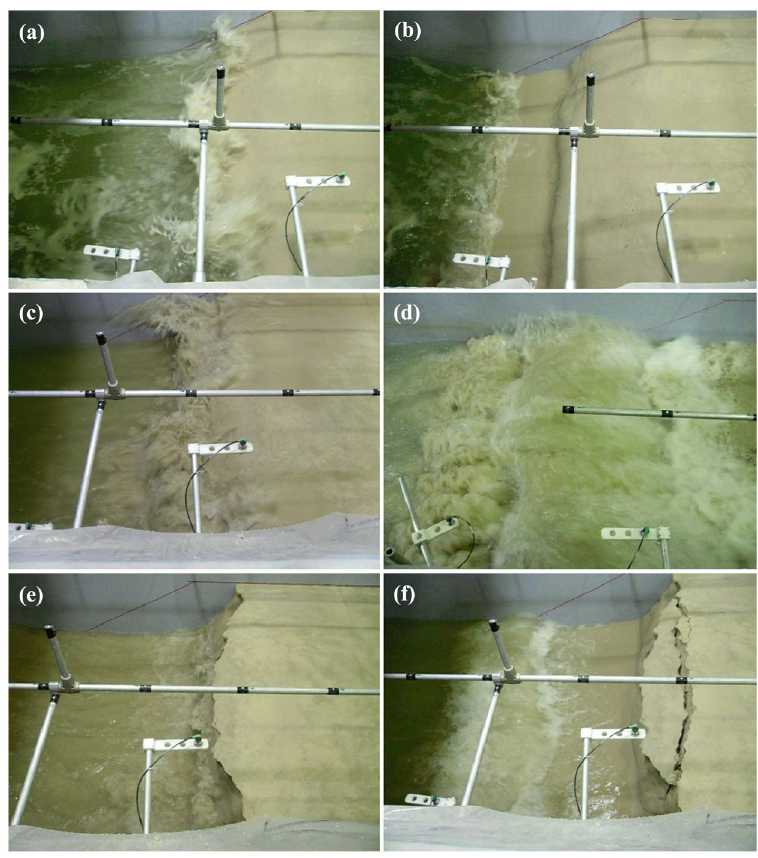
Figure 4. Observed collision regime. ( a ) Wave breaking on the sloping dune front, ( b ) formation of the dune scarp, ( c ) wave breaking and high sediment suspension in the proximity of the dune, ( d ) wave collision, ( e ) dune erosion, ( f ) collapsing of the dune face. Hydralab-III BOB project at CIEM wave flume. Photo courtesy of Felice D’Alessandro.